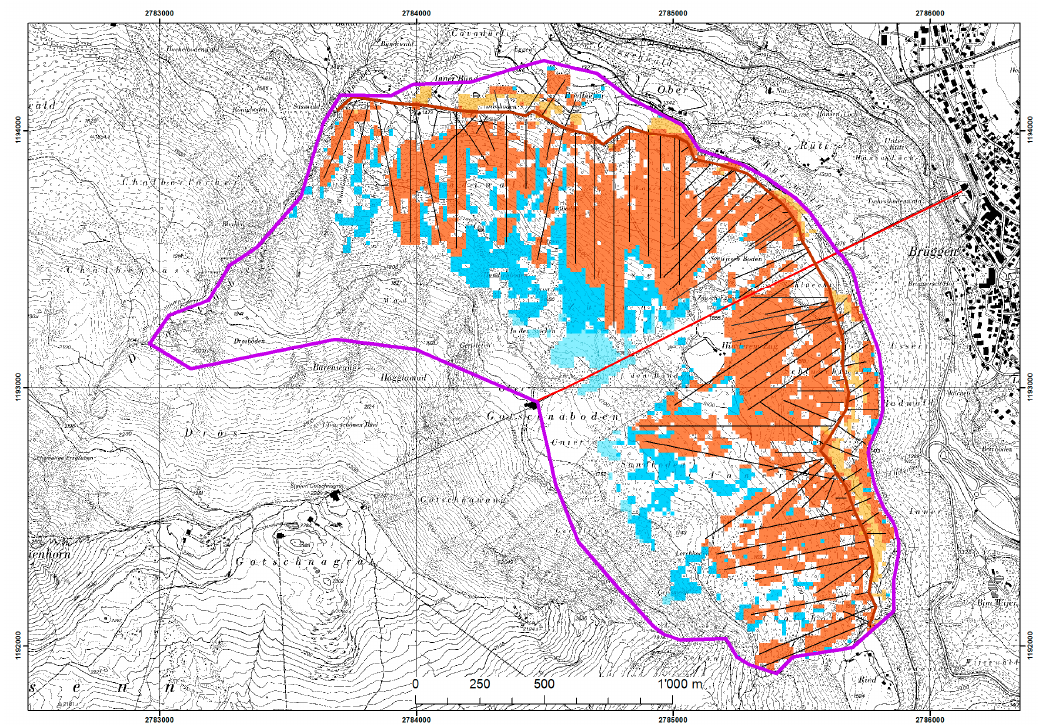
Figure 12. Harvesting and CR layout for MIX (multiobjective solution) (topographic map © swisstopo (JA100118)).